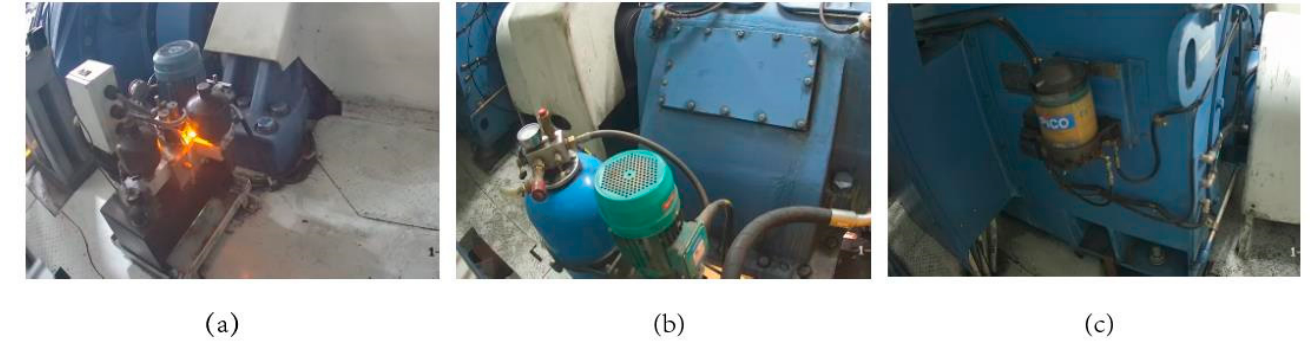
Figure 2. Multiple objects in the nacelle: ( a ) the hydraulic station, ( b ) the pump, ( c ) the oil box. The Labellimg annotation tool was used to annotate the collected 5000 images, and